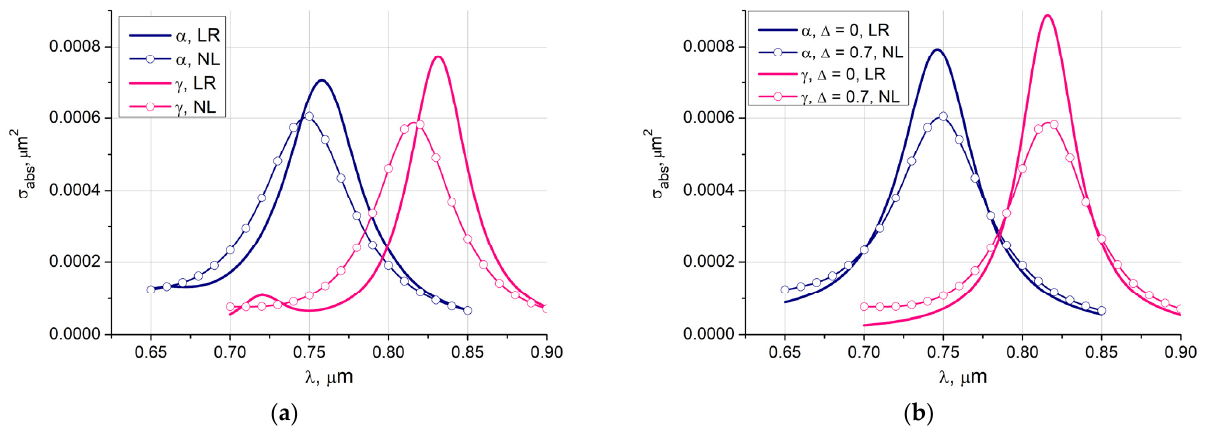
Figure 4. Absorption cross-sections of two particles with different magnetic core materials Fe 3 O 4 ( α ) and Fe 2 O 3 ( γ ), core diameter D = 16 nm, gold shell thickness d = 2 nm: ( a ) averaged local response (LR) and non-local response (NL) results for the particle with a shifted by Δ = 0.7 nm core; ( b ) local response (LR) curves for symmetrical core-shell particles and the averaged non-local response (LR) results for the particles with shifted cores.